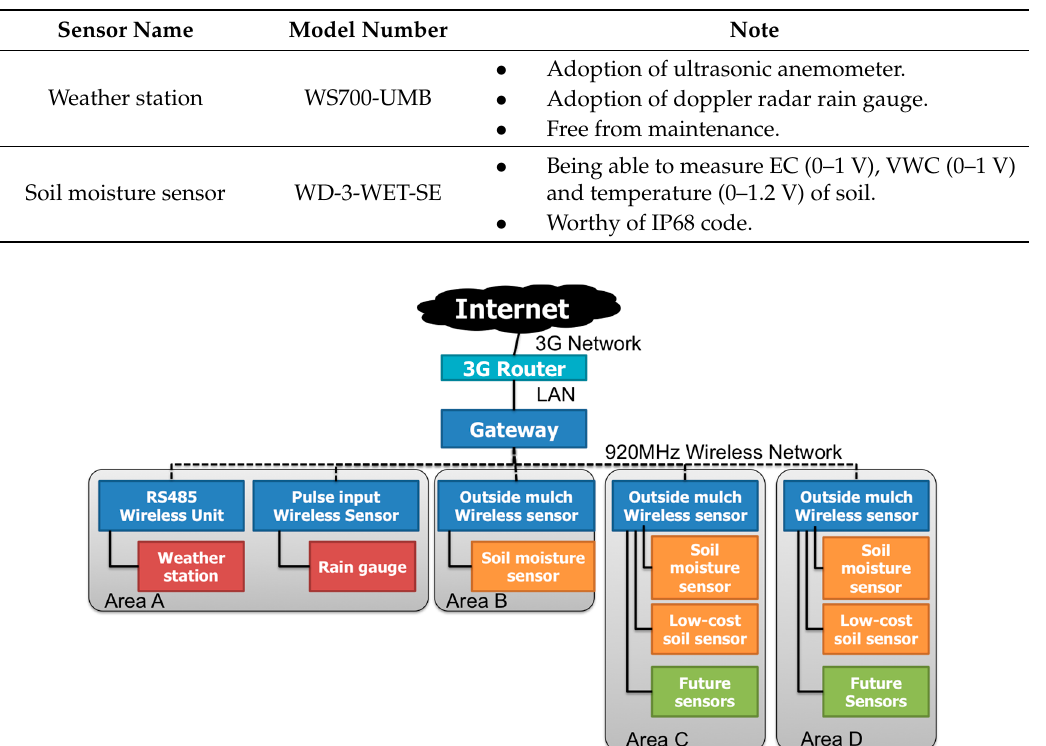
Figure 9. The structure of the WSN used in this study.